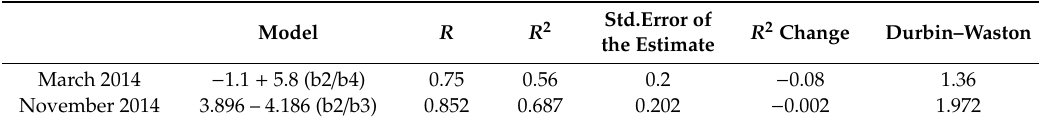
Table 5. Statistical summary and description of the final turbidity model that was computed for March and November 2014.